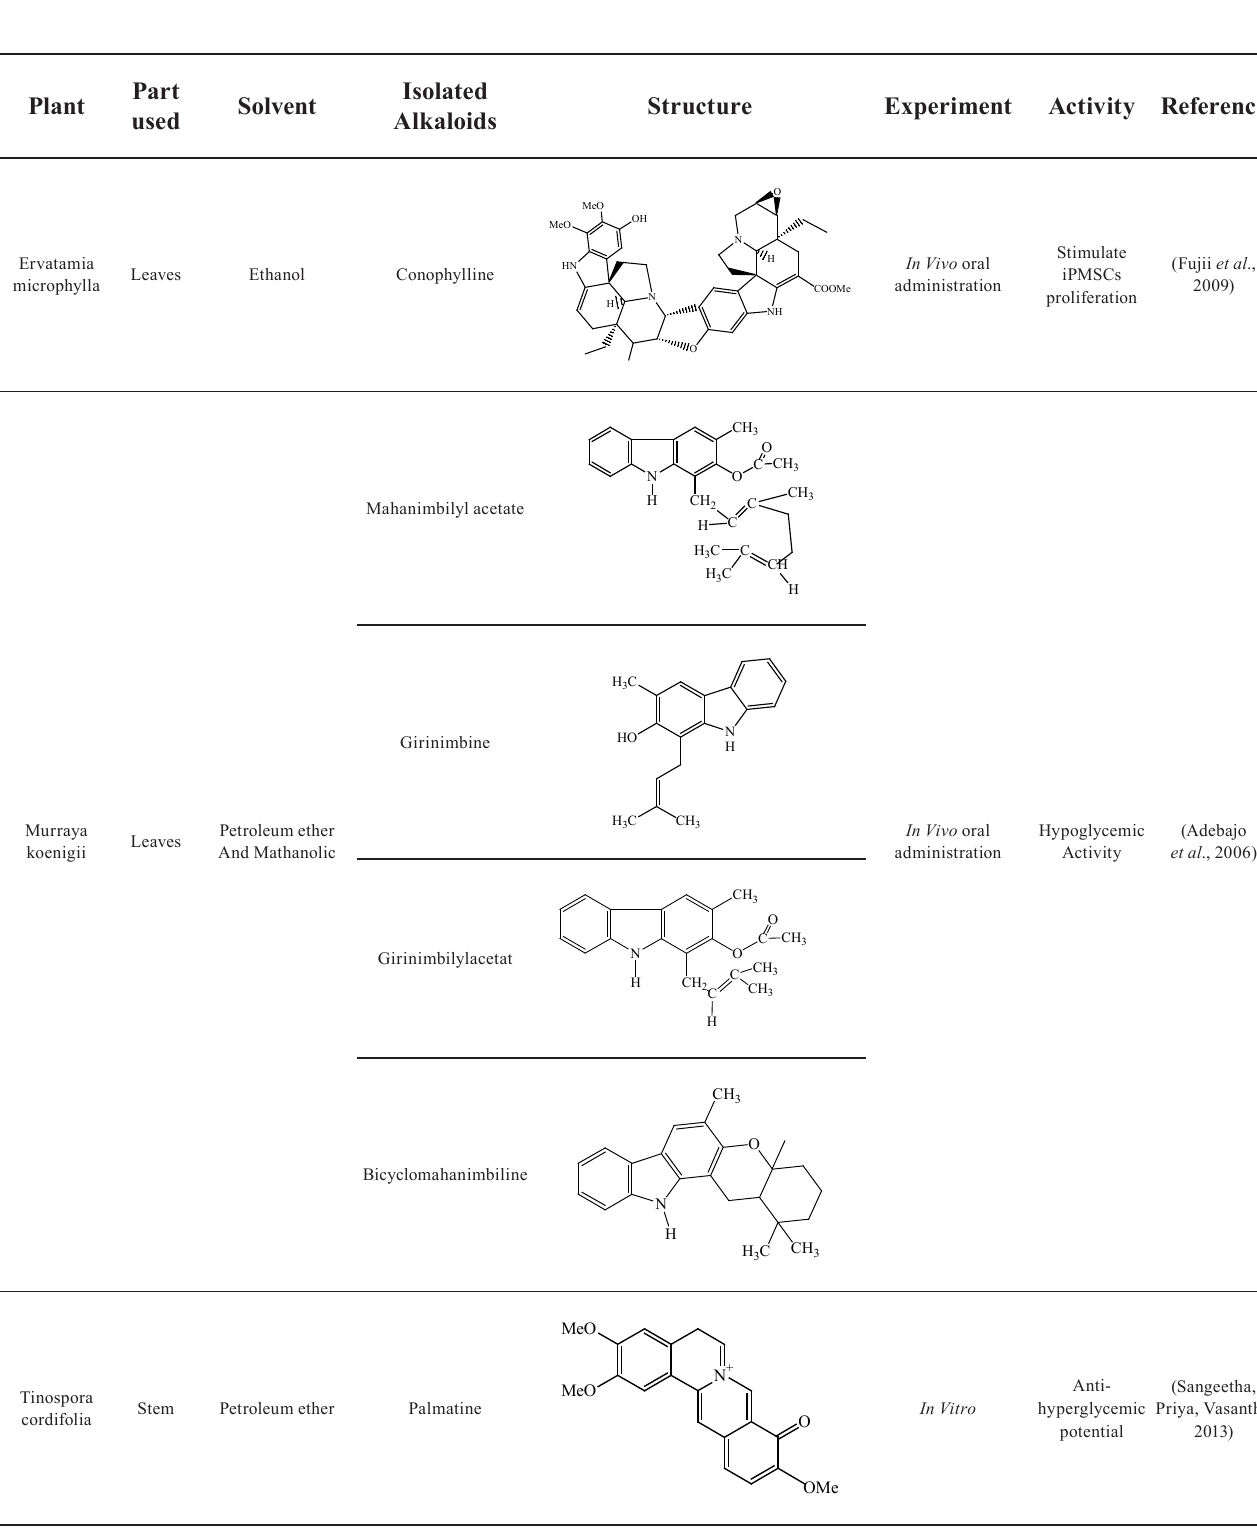
TABLE I – A lkaloids with anti-diabetic activity